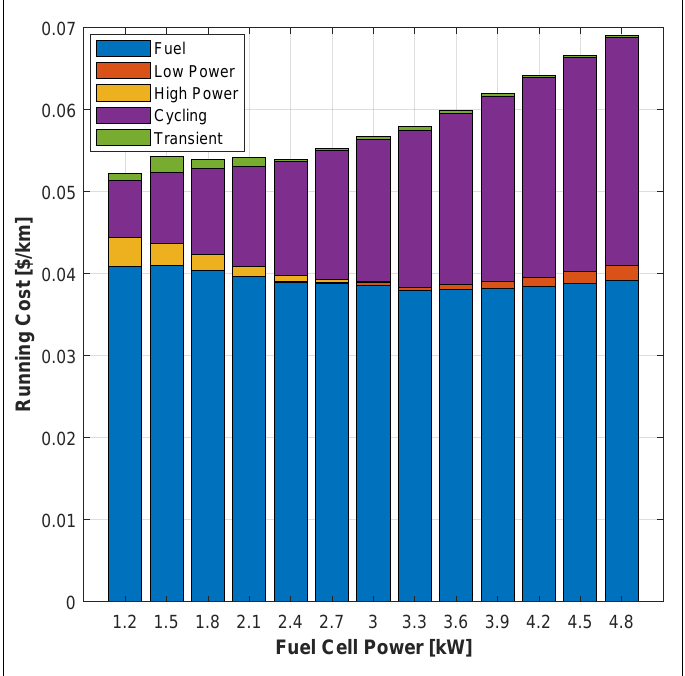
Figure 10. Breakdown of running cost using a 2.6 kWh battery (Note: 1.2 kW and 1.5 kW fuel cells were unable to complete the test cycles, see Figure